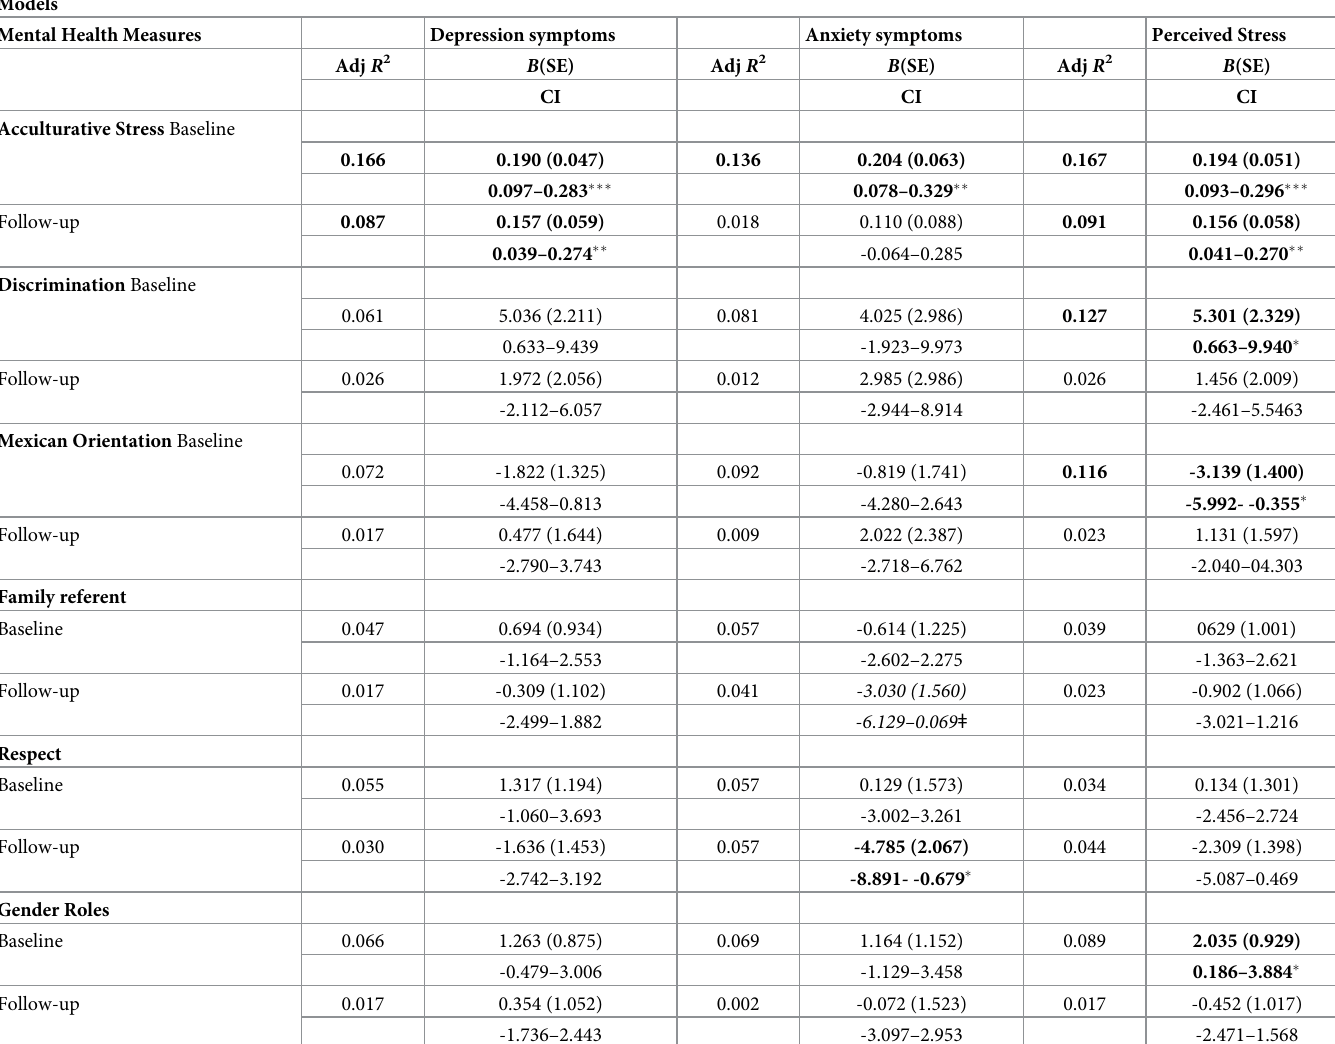
Table 5. Multiple regression models of maternal sociocultural stressors and protective factors explaining mental health variables at baseline and follow-up in bor- der city ( n = 78–84 both baseline and